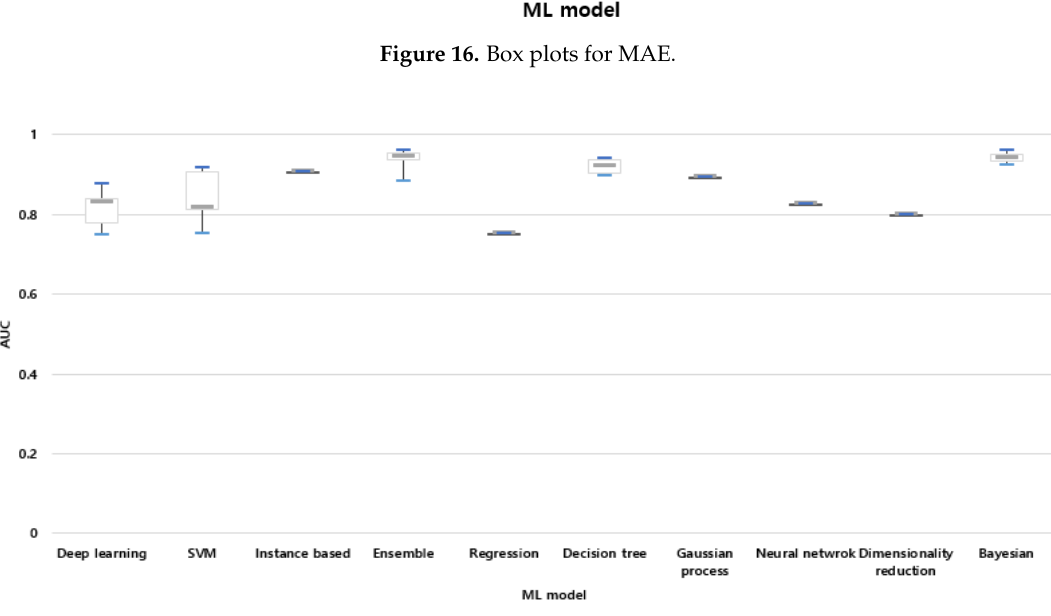
Figure 17. Box plots for AUC.